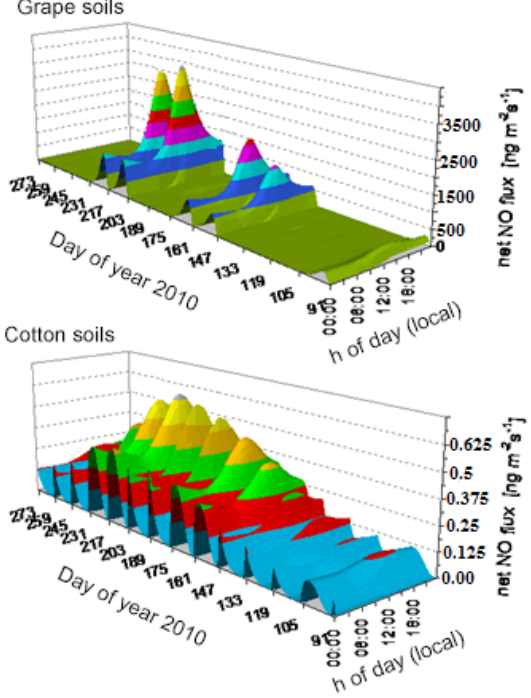
Figure 7. Seasonal variation in diel net NO flux (at 30min resolu- tion) for grape soils and cotton fields of the Tohsun Oasis for the entire growing period of 2010 (01 April (DOY 90)–30 September (DOY 273)). All data are given in terms of mass of